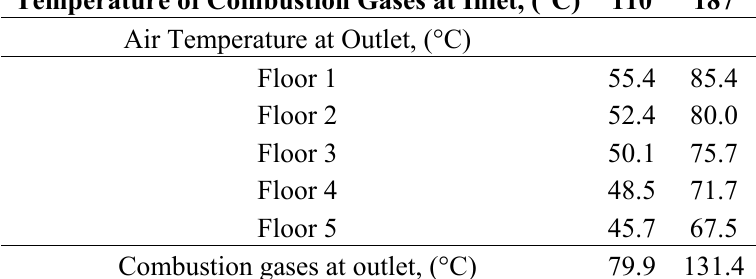
Table 7. Calculated temperature of combustion gases and air for the collective concentric chimney and air-supply duct